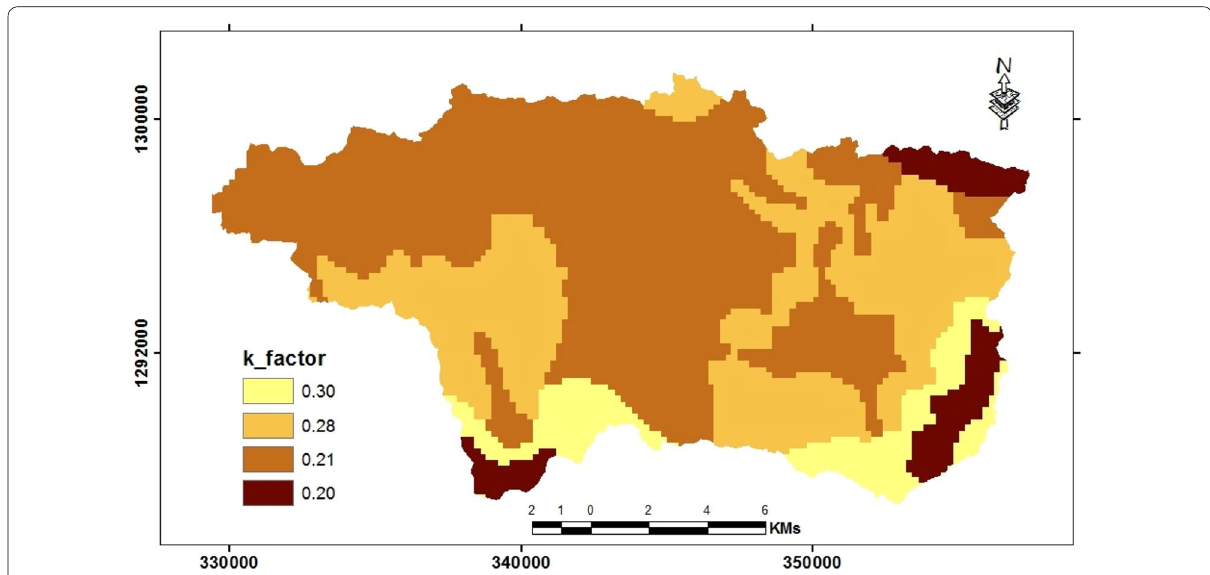
Fig. 6 Soil erodibility (K-factor) map of Gelda catchment, Northwestern highlands of Ethiopia